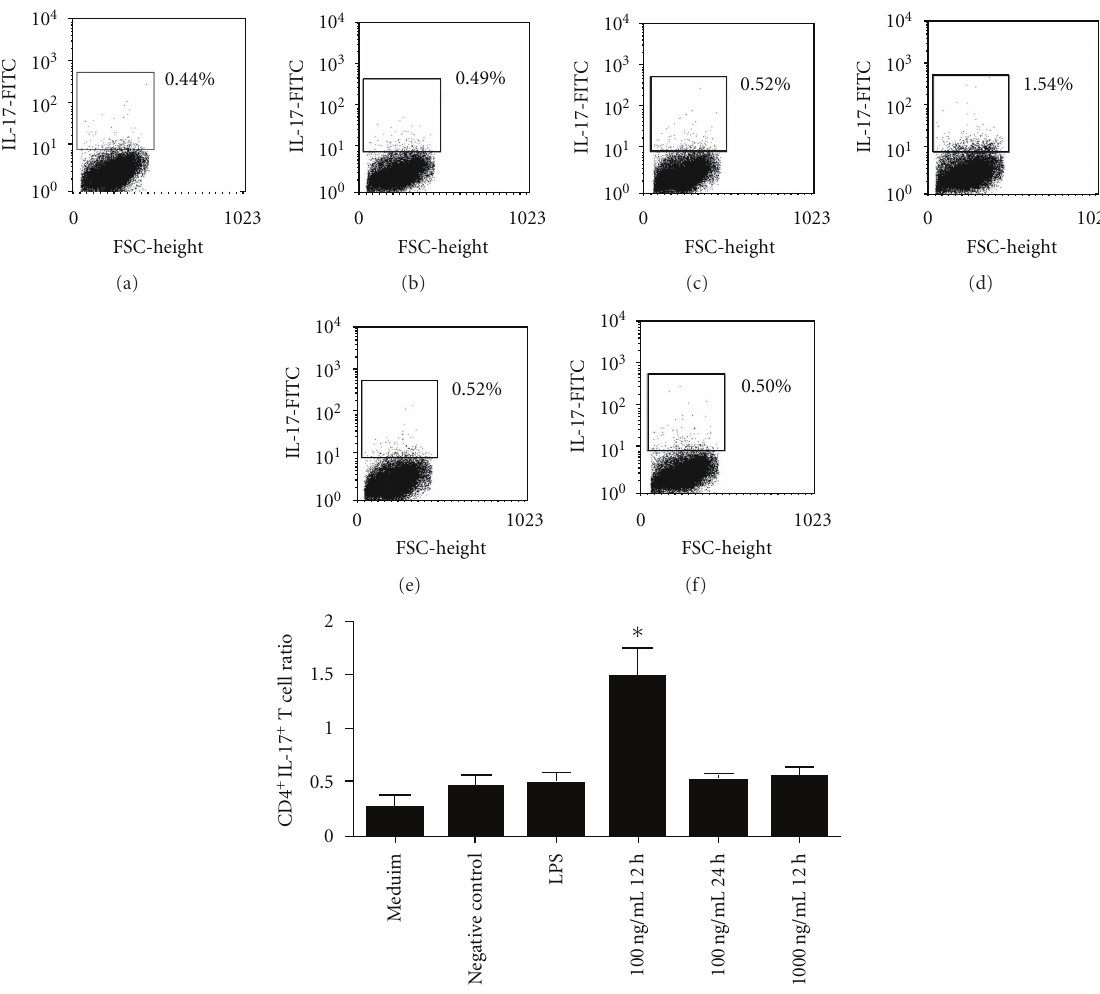
Figure 5: The number of IL-17-expressed CD4 + T cell stimulated by HMGB 1. The conditions were designed as before. The cells were collected; before 6h, 1 μ L monosion, 5 μ L 10ng/mL PMA, and 1 μ L 1Mm/mL inon were added. (a) Presents medium control, stimulated for 12h; (b) Presents independence protein, stimulated for 12h; (c) Presents LPS, stimulated for 12 h; (d) Presents 100 ng/mL HMGB 1 stimulated for 12h; (e) Presents 100 ng/mL HMGB 1 stimulated for 24 h; (f) Presents 1000 ng/mL HMGB 1 stimulated for 12h. between HMGB1 and Th17 or other clinical index.